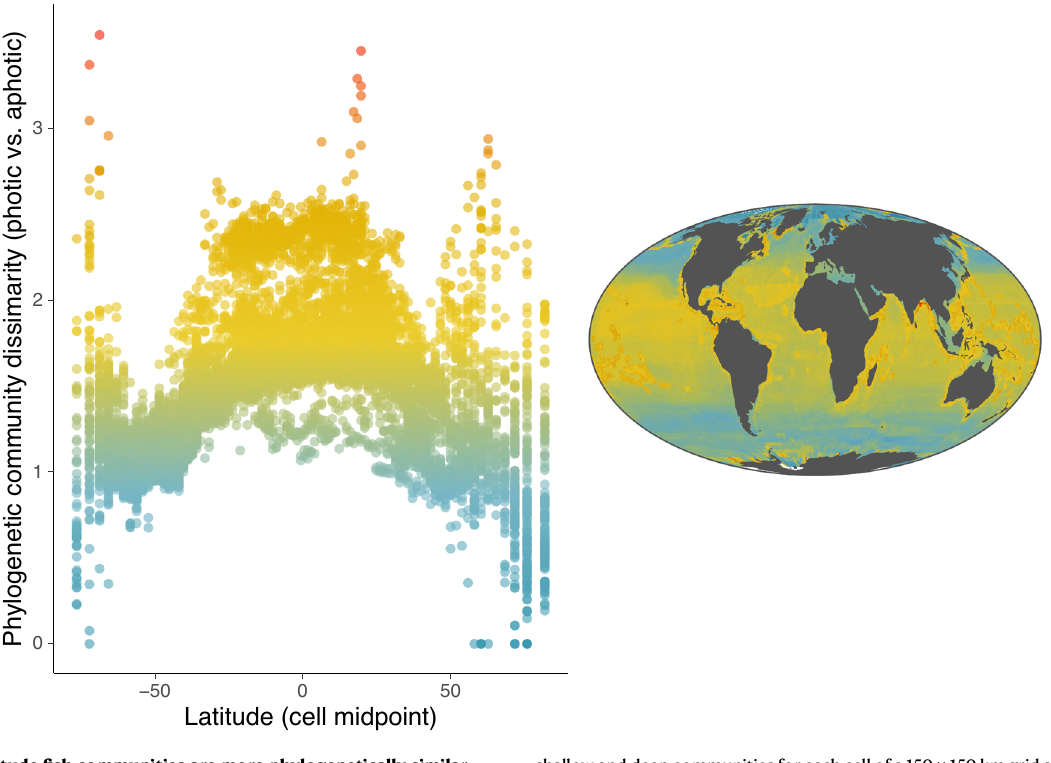
shallowanddeepcommunitiesforeachcellofa150×150kmgridacrosstheglobe. Low values (blue) indicate greater phylogenetic similarity between shallow and deep fi sh communities. Source data are provided as a Source Data fi le.